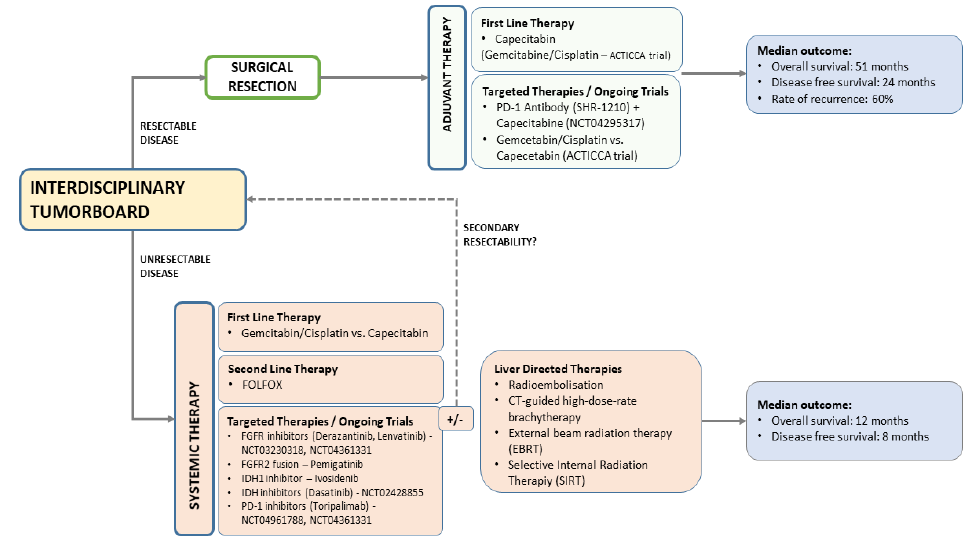
Figure 2. Therapy algorithm of intrahepatic cholangiocarcinoma.